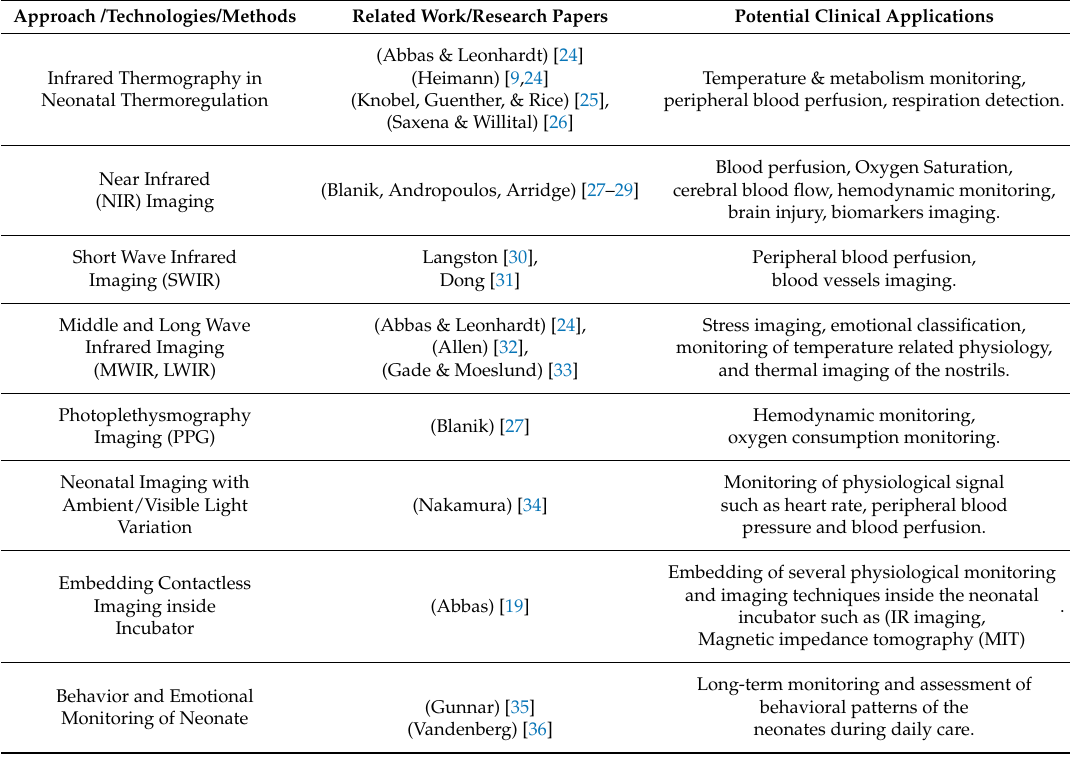
Table 1. Overview of research using imaging modalities.